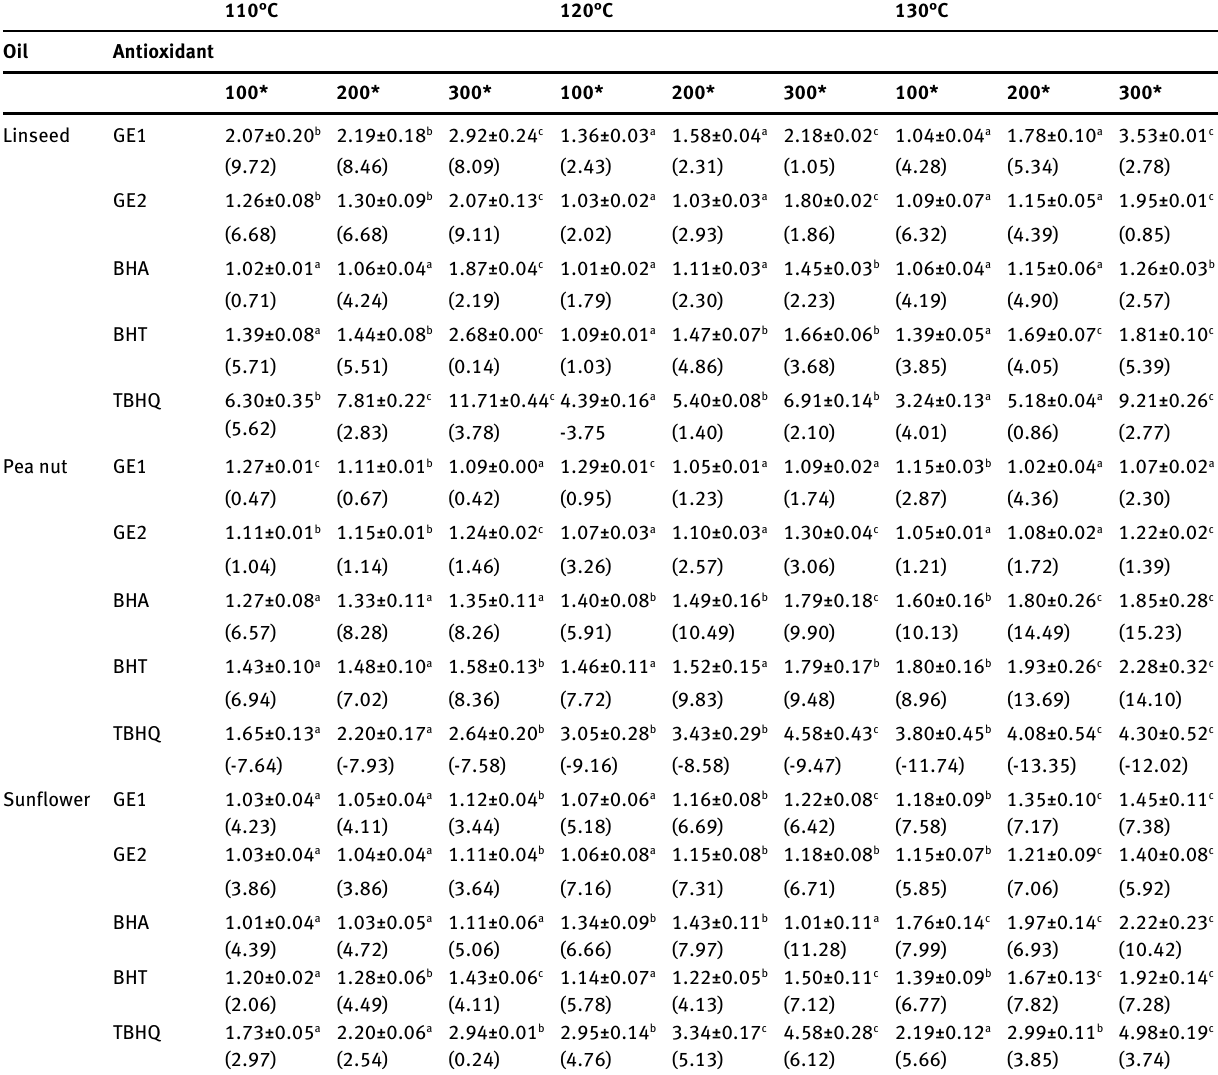
Table 2: Effect of temperature and antioxidant concentrations on antioxidant index and stability of oil